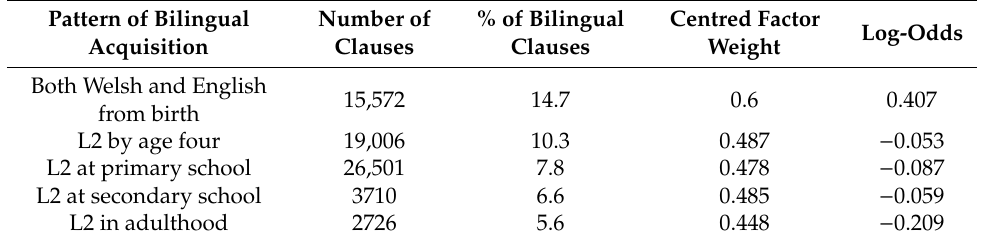
Table 1. 6 Mixed e ff ects logistic regression predicting bilingual clauses with speaker as a random e ff ect.